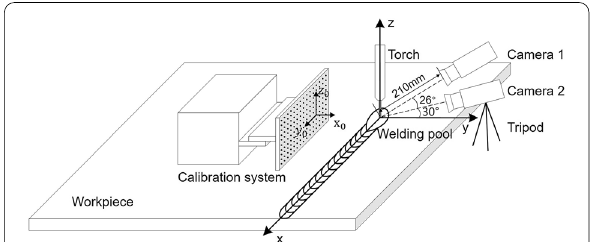
Figure 1 Binocular vision